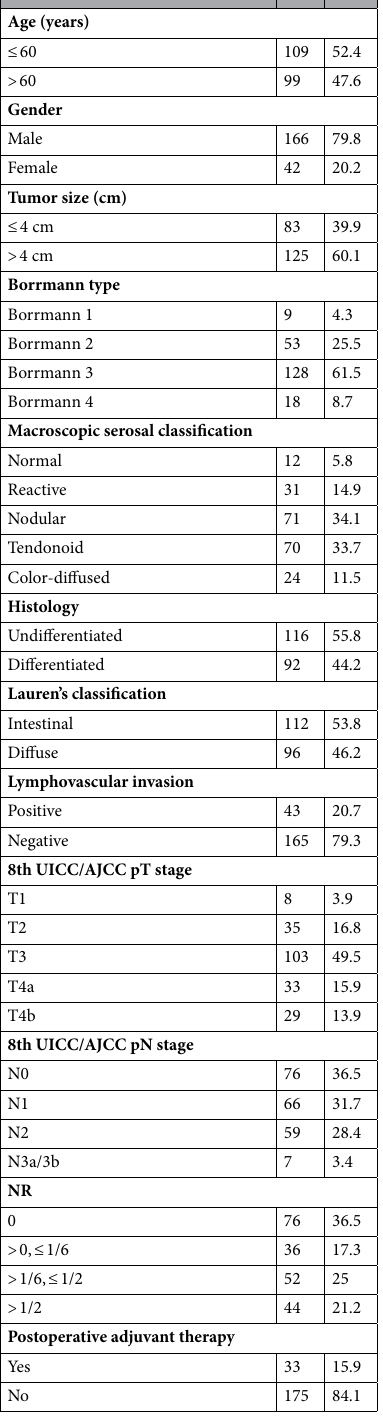
Table 1. Descriptive data of the patients involved in this cohort (n = 208). UICC union for international cancer control, AJCC American joint committee on cancer, NR lymph node